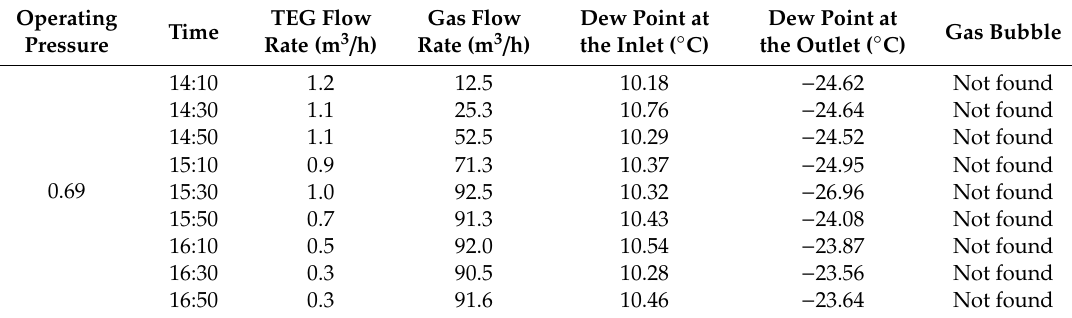
Table 11. Experimental results under continuous operating